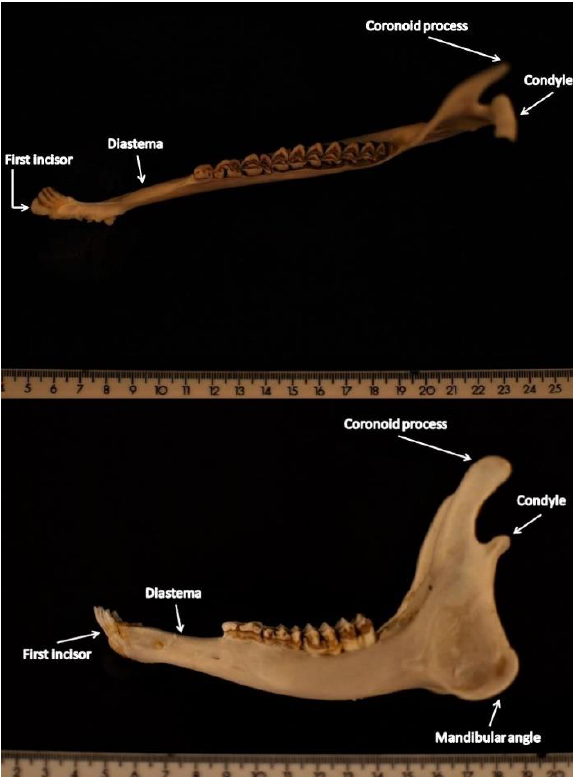
Figure 2. On the top: view of the dorsal side of the mandible. On the bottom: view of the lateral side of the mandible.